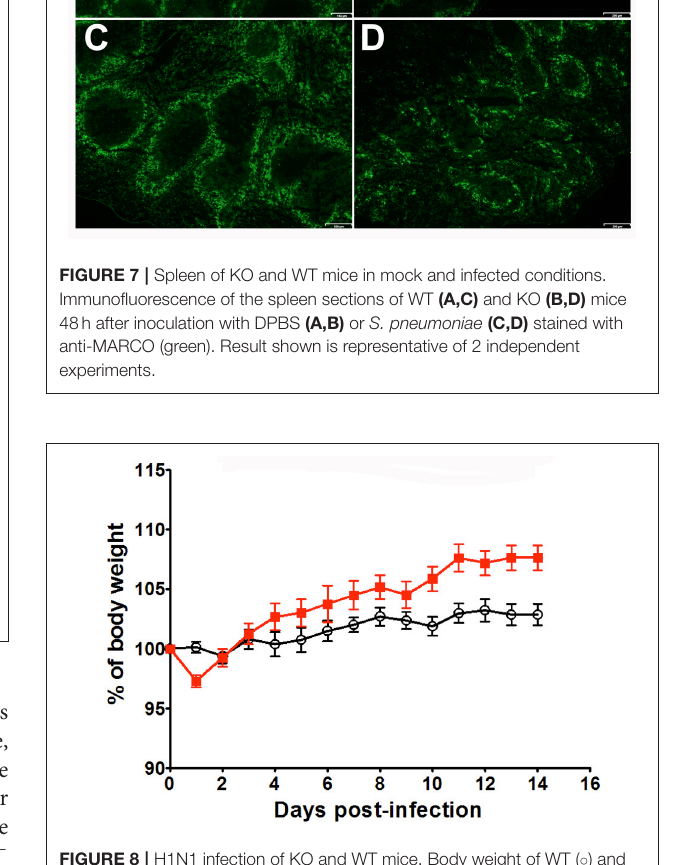
FIGURE 8 | H1N1 infection of KO and WT mice. Body weight of WT ( ◦ ) and KO ( ) mice was measured after H1N1 infection, for 14 days by using sublethal dose (9pfu). Results are presented as mean ± SEM. N = 7 mice per